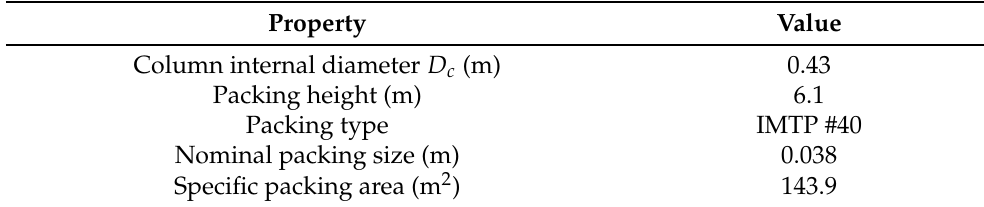
Table 2. CO 2 gas absorption column configuration.